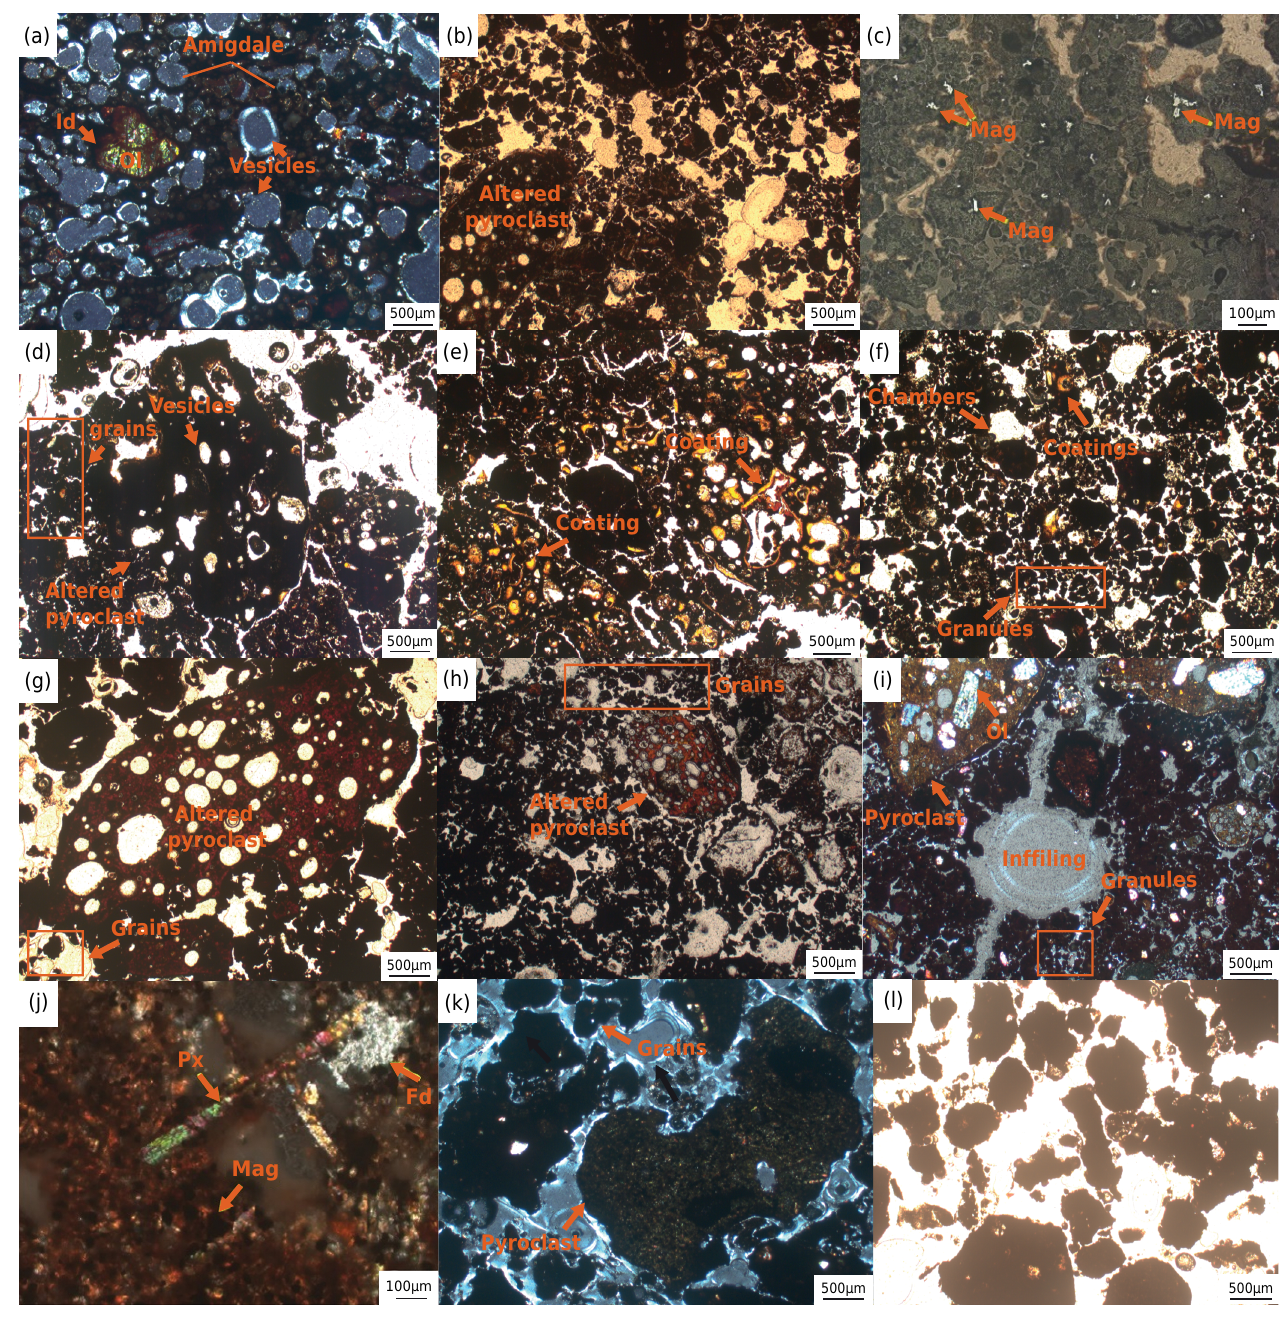
Figure 3. XPL photomicrograph of pyroclasts from P1 showing vesicles and olivine iddingsitized (a). PPL photomicrograph of C2 horizon from P1 showing altered vesicular pyroclasts and a simple grains microstructure evidenced by c/f related distribution is coarse monic (b). Reflected light photomicrograph of C1 horizon from P1 showing magnetite crystals in the clay matrix and pyroclast fragments (c). PPL photomicrograph of Bi horizon from P1 showing altered pyroclast fragments divided into smaller fragments (d). PPL photomicrograph of Bi horizon from P1 showing coatings of clay and c/f chitonic distribution (e). PPL photomicrograph of A horizon from P1 showing granular and intergrain microaggregate microstructures and coating of clay (f). PPL photomicrograph of C horizon from P2 showing pyroclast fragment with sideromelane totally palagonitized and grains of altered pyroclasts of 250mm (g). PPL photomicrograph of C2 horizon from P3 showing simple grains (h). XPL photomicrograph of A horizon from P3 showing pyroclast fragment with unaltered Ol, granules of clay aggregates with undifferentiated b-fabric and infilling (i). XPL photomicrograph of C2 horizon from P4 showing pyroclast fragment with pyroxenes, magnetites and feldspar (j). XPL photomicrograph of C1 horizon from P4 showing pyroclast fragment and aggregates of clay (k). PPL photomicrograph of A horizon from P4 showing granular microstructure (l). Ol: olivine; Id: iddingsite; Px: pyroxene; Mag: magnetite; Fd: feldspar; XPL: crossed polarized light; PPL: plane polarized